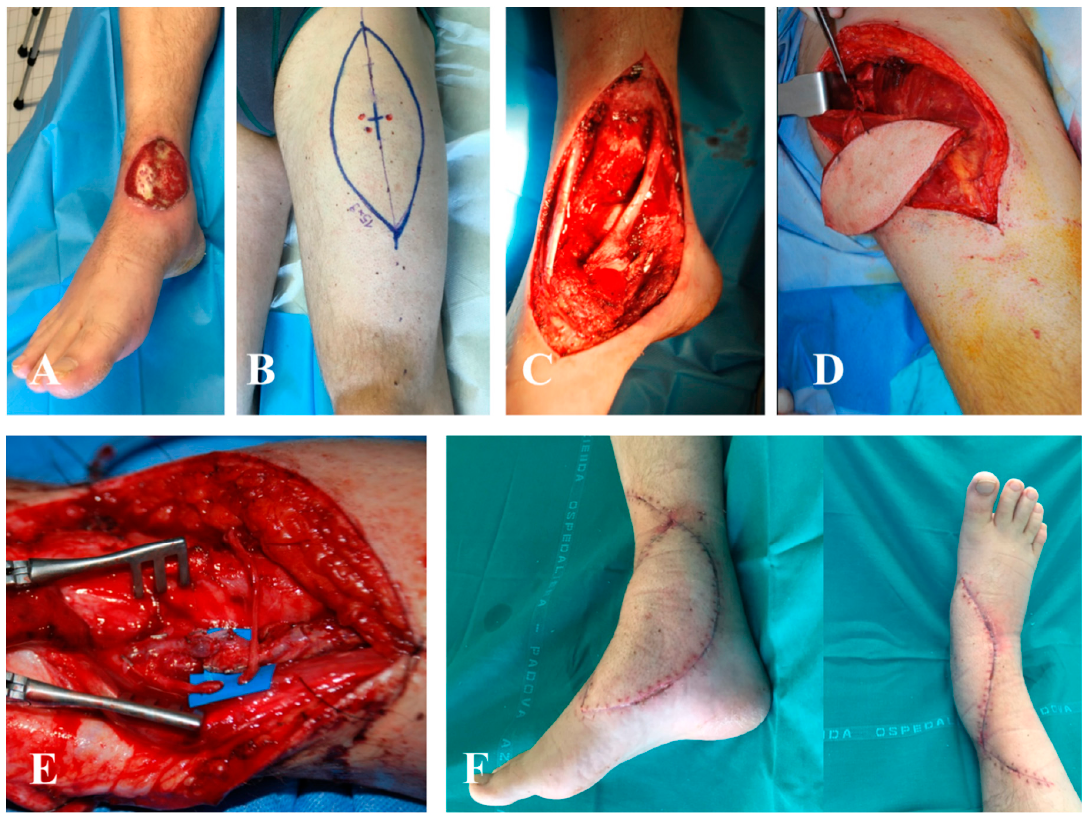
Figure 4. Case of an unplanned excision of sarcoma of the ankle. Wide margin resection of the tumor bed was required. ( A ) Preoperative defect of the ankle and ( B ) the Doppler map of antero-lateral thigh (ALT) perforators. ( C ) Particular of the wide margin excision and ( D ) of the positioning of the ALT free flap to reconstruct the area. ( E ) Microsurgical particular of the arterial anastomosis. ( F ) Follow-up at 3 months.